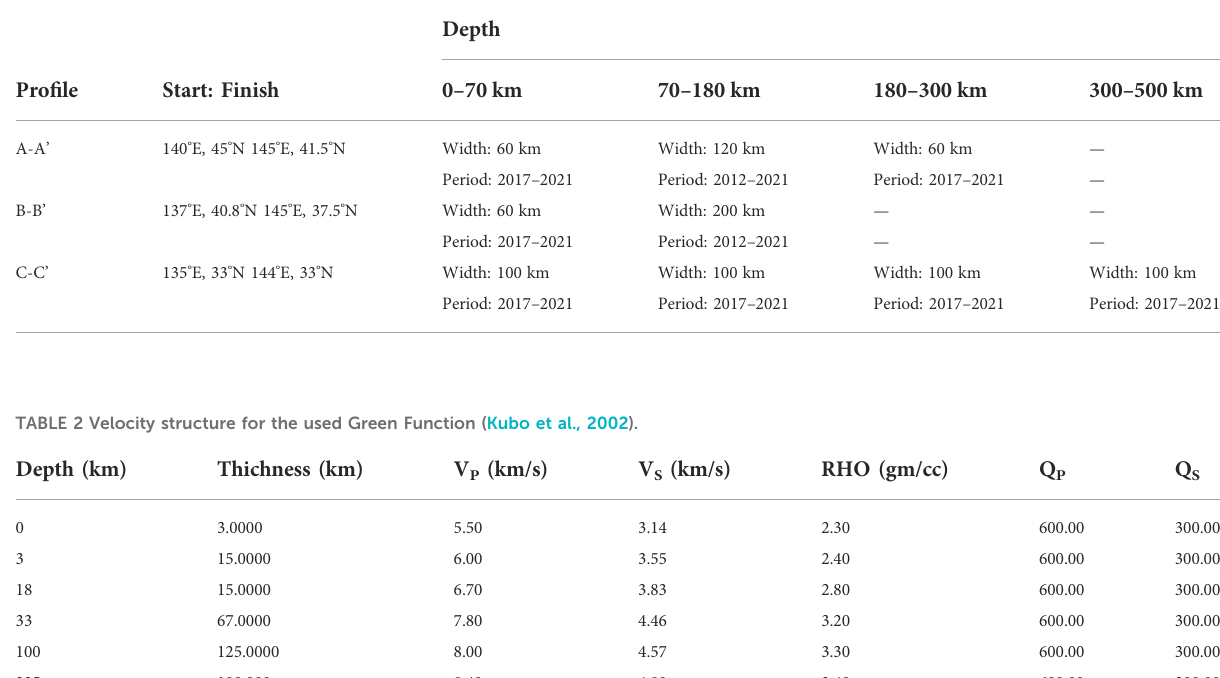
TABLE 1 The information of each pro fi le.